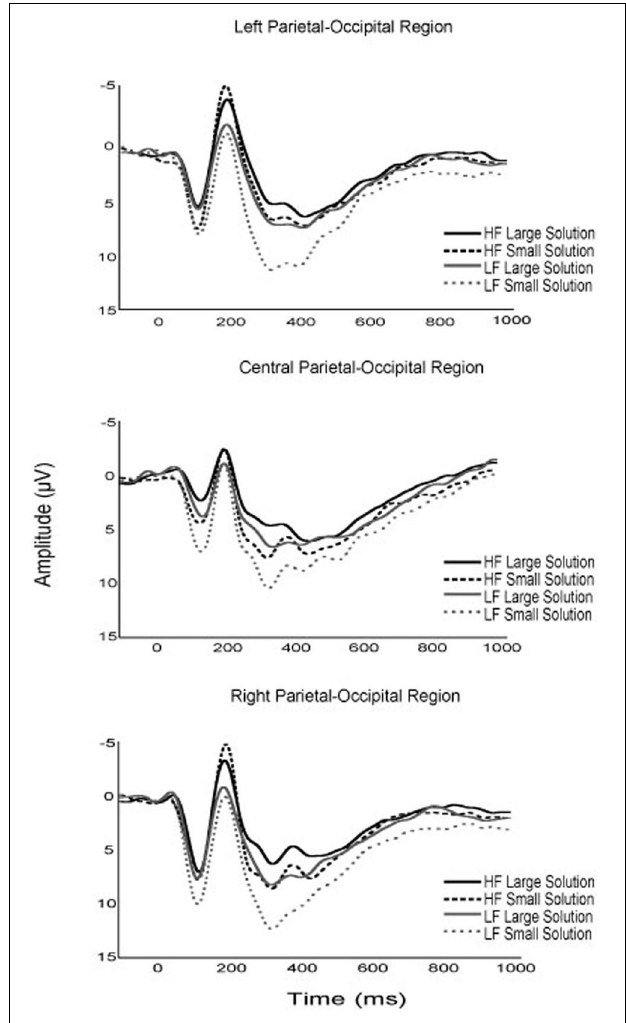
FIGURE 3 | Grand average waveforms of the P1, N170, and P3 components for higher and lower fit participants, for correct and incorrect experimental task solutions.